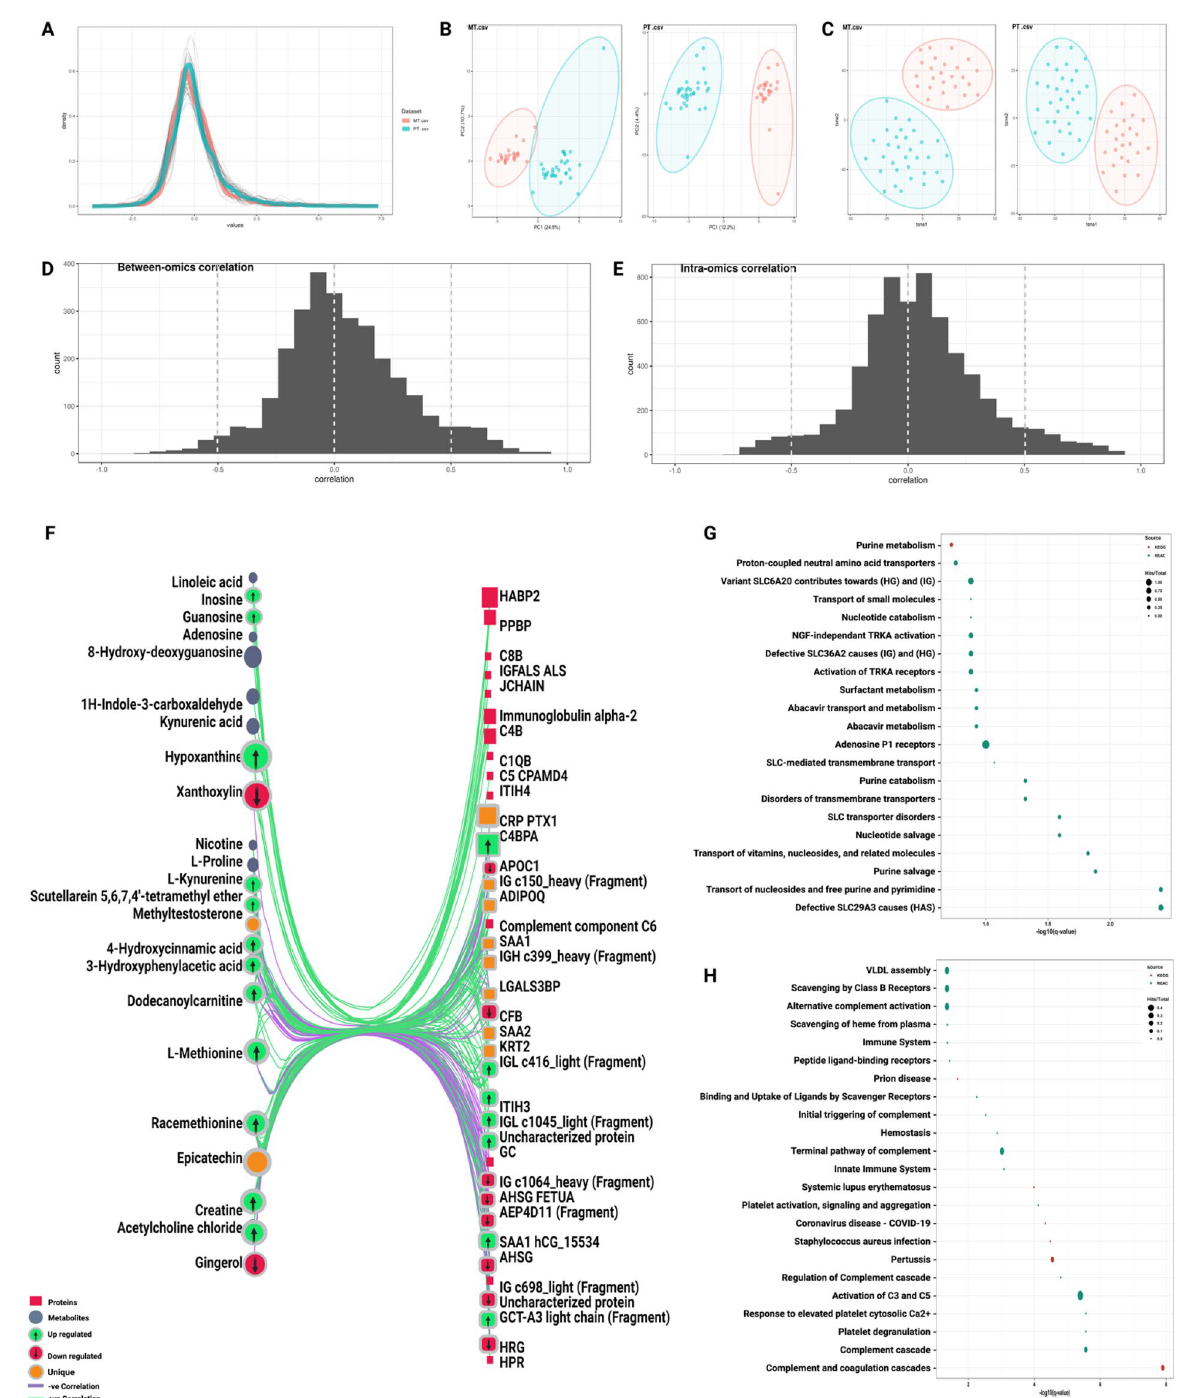
Figure 3. Statistical-based correlation between plasma proteins and metabolites. ( A ) Alignment and distribution of proteomic and metabolomic datasets after the auto-scaling and prior to integration. ( B , C) PCA and t-SNE plots for both omics among healthy individuals and COVID-19 patients ( D , E ) correlation between and intra-omics datasets ( F ) The Statistical-based network contains 37 proteins labeled in red and 23 metabolites labeled in blue, with 64 negative correlation edges highlighted in purple and 179 positive correlation edges highlighted in green. ( G , H ) Pathway enrichment analyses applied on the statistical-based network and retrieved from KEGG (red) and Reactome (green) databases. The circle size reflects the number of identified hits in the pathway divided by the total entities within the same pathway. The x-axis represents the –log10 of the